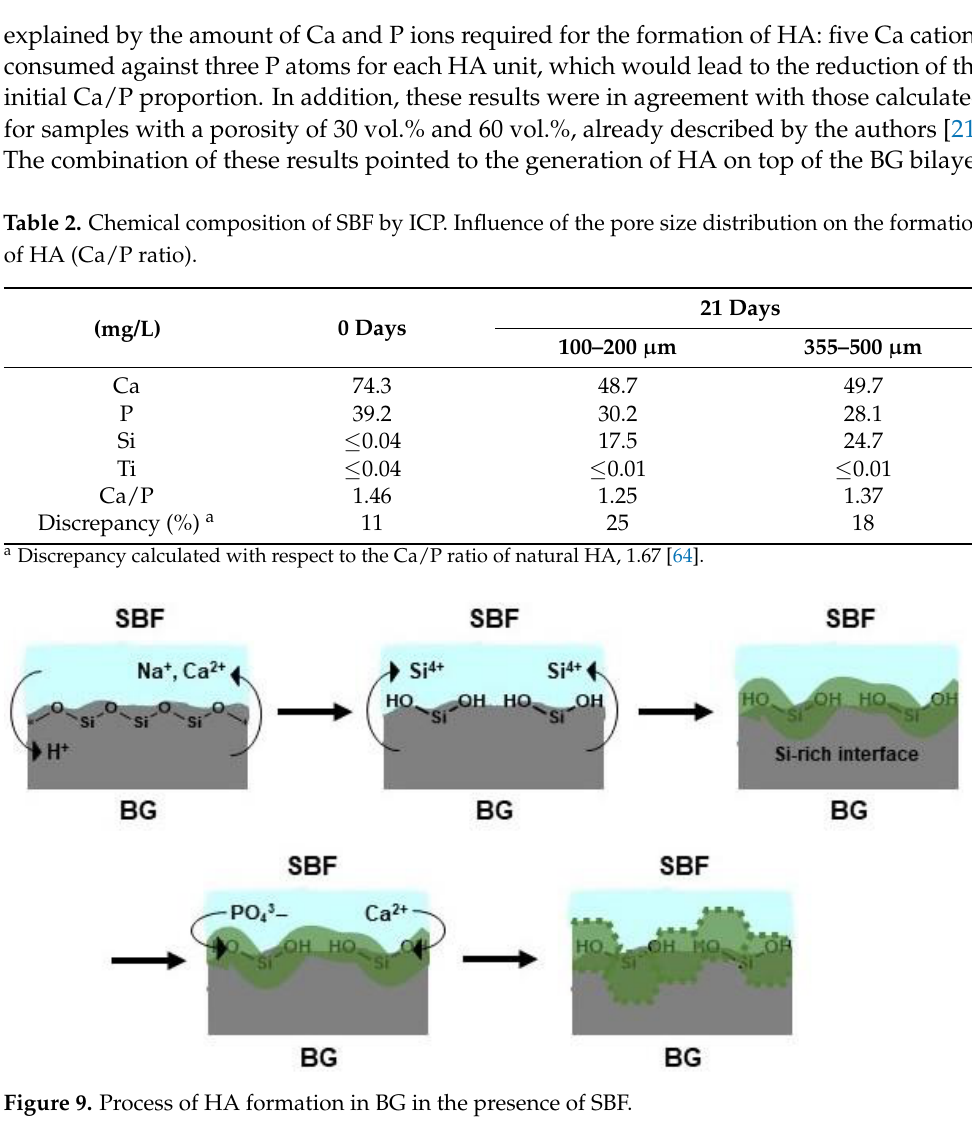
Table 2. Chemical composition of SBF by ICP. Influence of the pore size distribution on the for- mation of HA (Ca/P ratio).